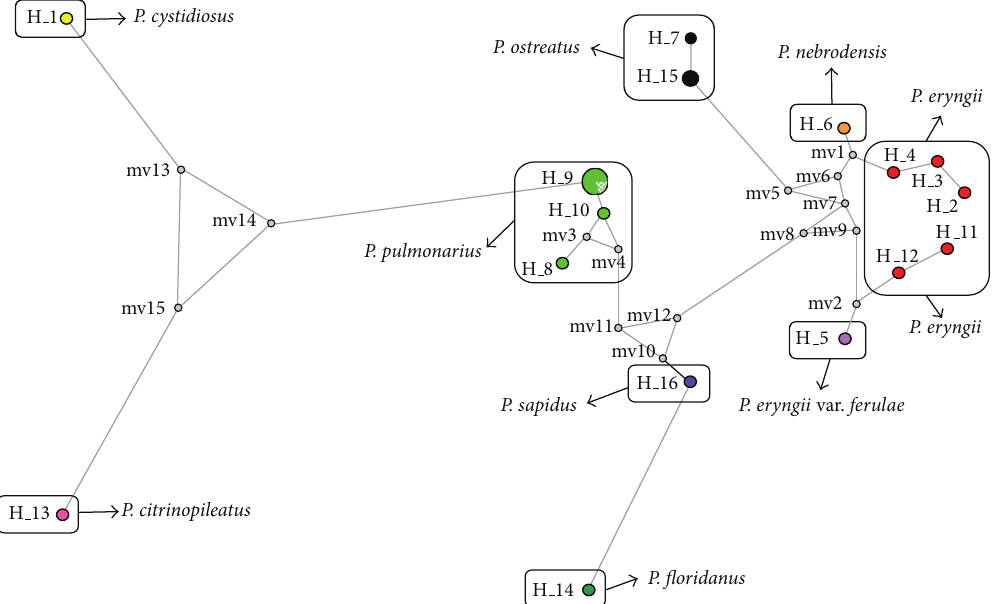
Figure 3: The median joining haplotype network of the combined IGS1 and ITS sequences. H and MV indicate haplotype and median vector,